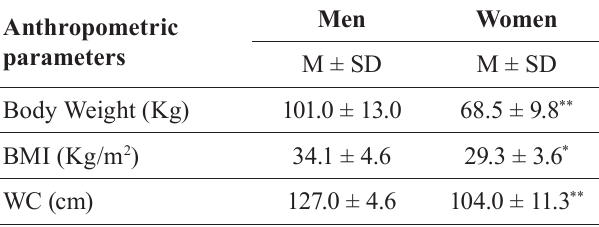
BMI = Body Mass Index; WC = Waist